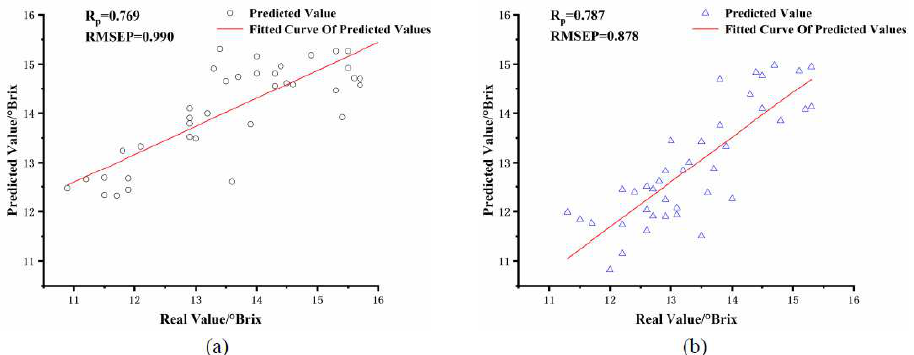
Figure 4. Scatter plot of PLSR with different fruit diameter of modeling set and prediction set. ( a ) 75–85 mm apple size group predicted 65–75 mm apple size group, ( b ) 75–85 mm apple size group predicted 85–95 mm apple size group.